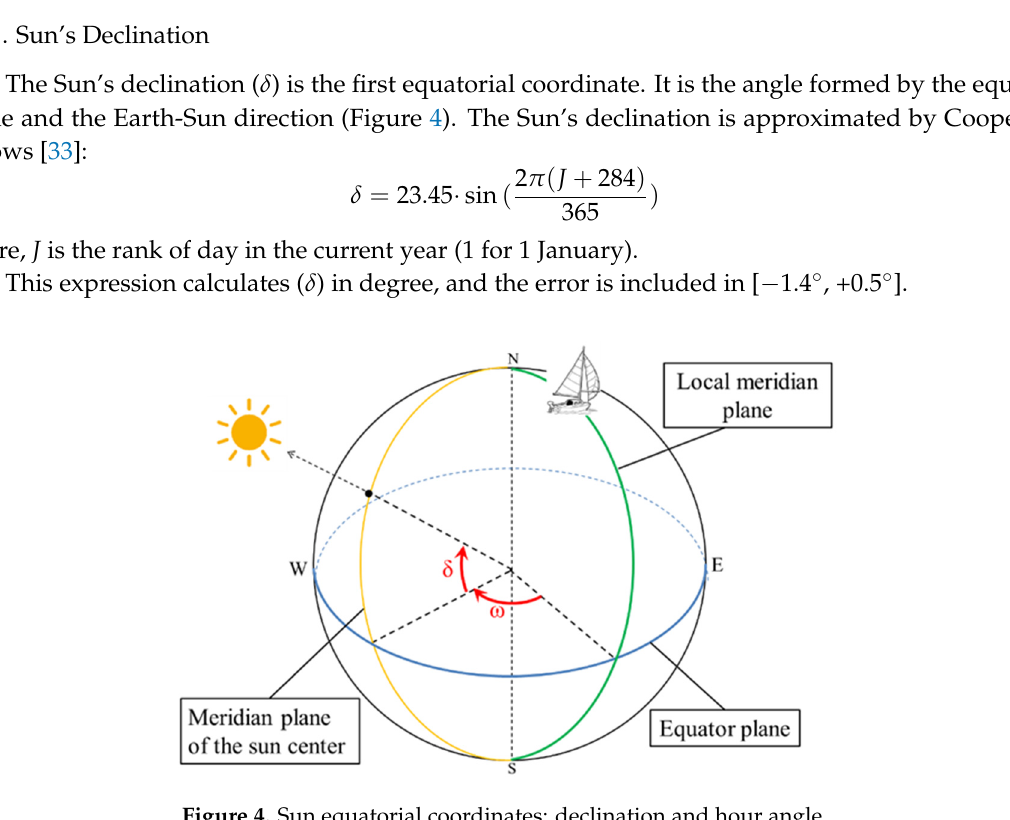
Figure 4. Sun equatorial coordinates: declination and hour angle.